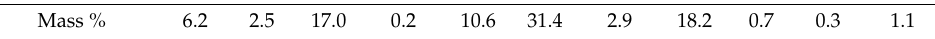
Figure 1. Schematic geographic map of Zambia superimposed with the location of Kabwe and historic Pb-Zn mine wastes. Table 1. Chemical composition of zinc plant leach residues from Pb-Zn mine wastes from Kabwe, Zambia.